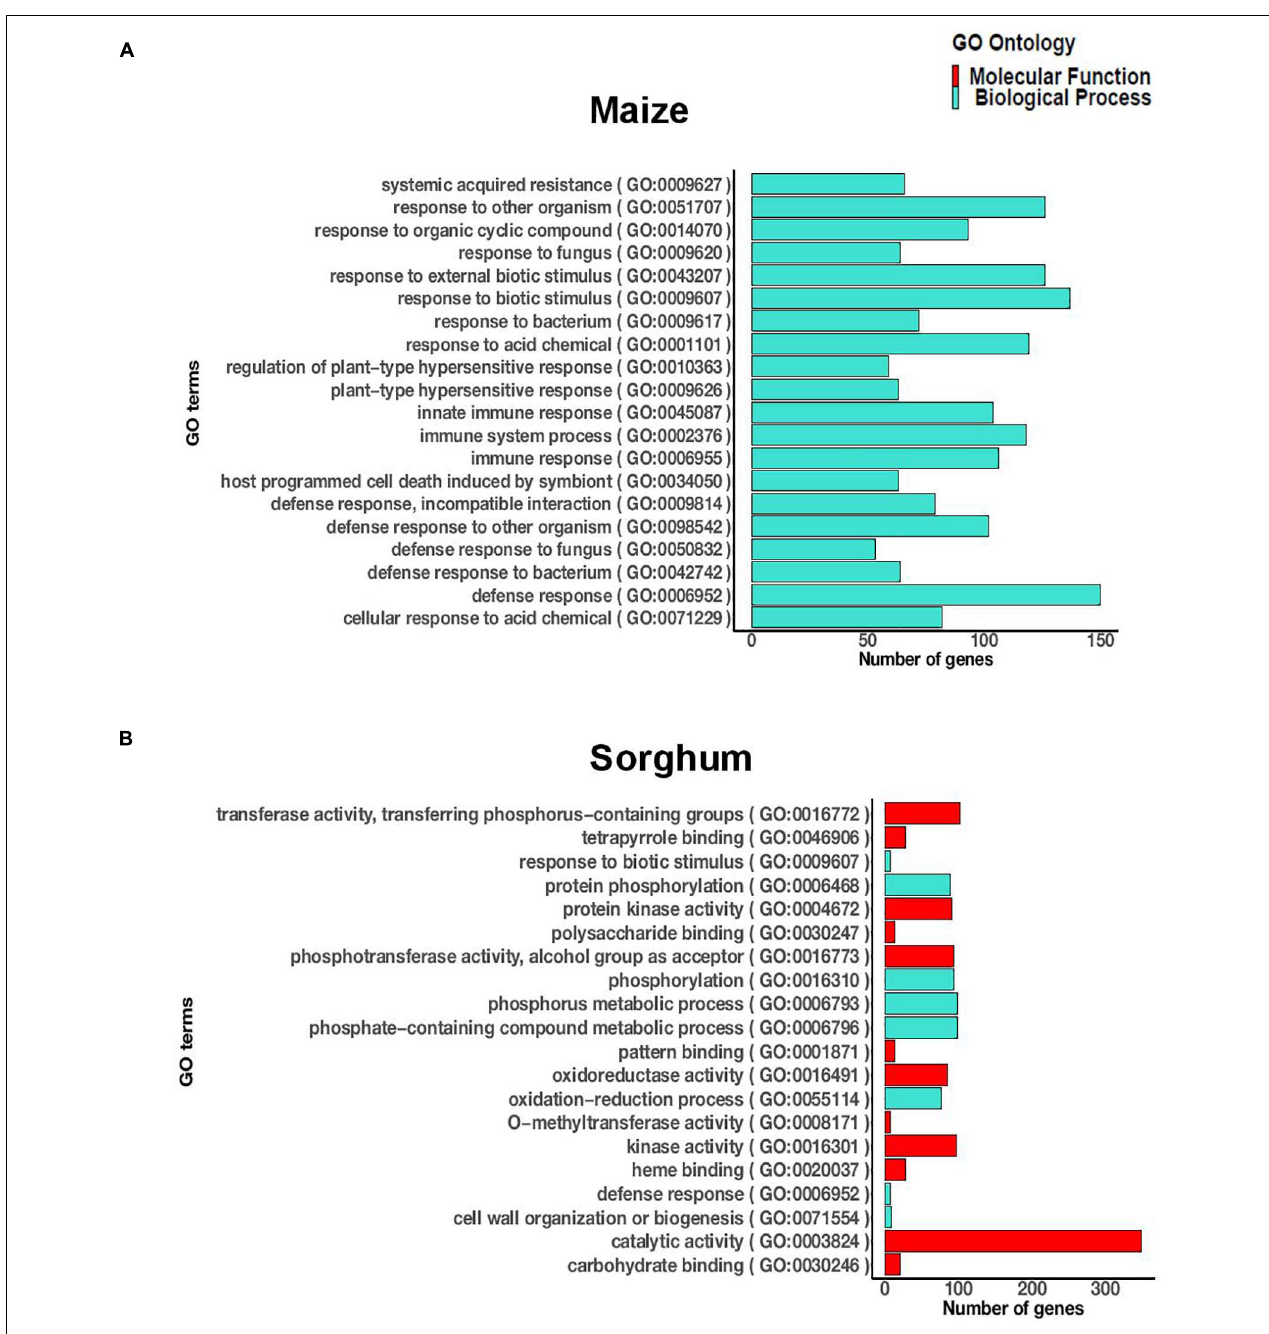
FIGURE 1 | The 20 most significantly enriched GO terms (FDR < 0.05) during the incompatible interaction at 72 h after inoculation in (A) maize and (B) sorghum.